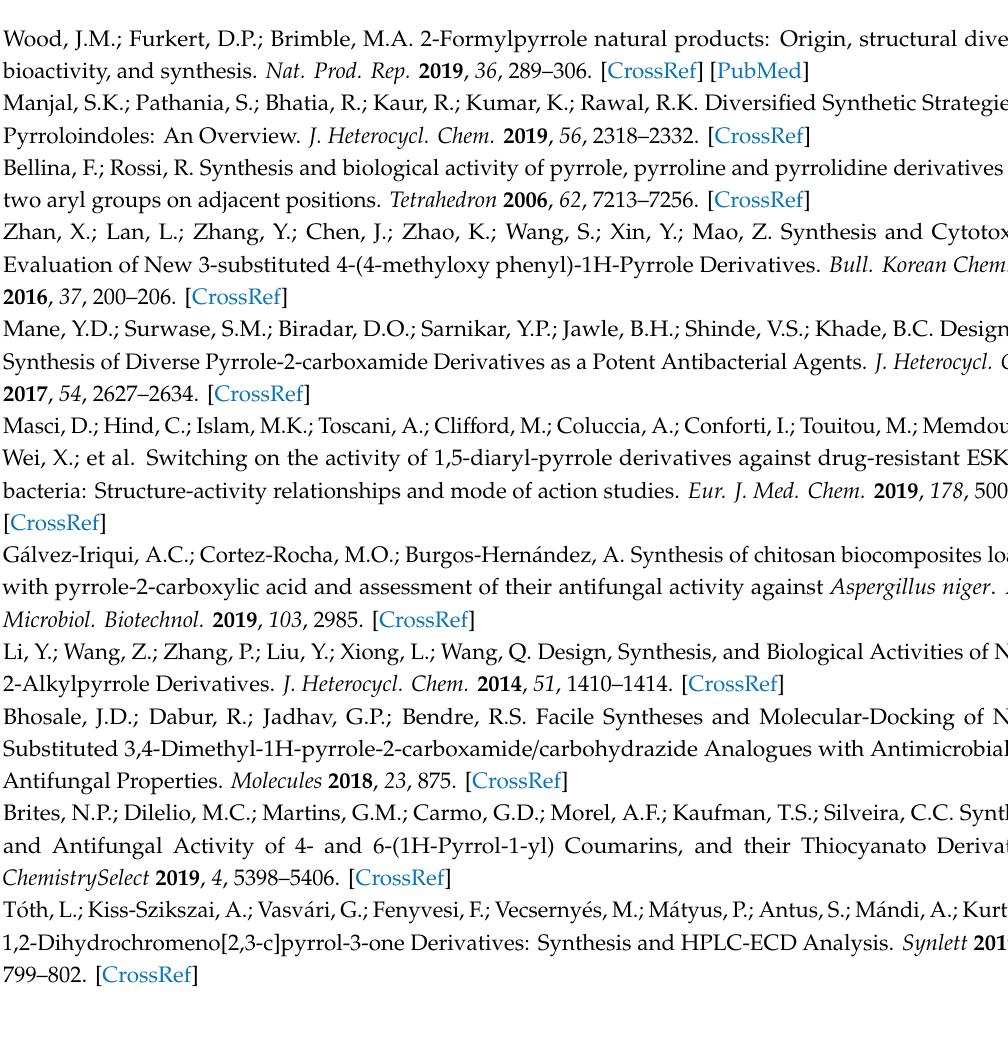
Supplementary Materials: The following are available online. Figure S1: 1 H NMR spectrum of 1a in CDCl 3 , Figure S2: 13 C NMR spectrum of 1a in CDCl 3 , Figure S3. HR-MS spectrum of compound 1a , Figure S4: 1 H NMR spectrum of 1b in CDCl 3 , Figure S5: 13 C NMR spectrum of 1b in CDCl 3 , Figure S6. HR-MS spectrum of compound 1b , Figure S7: 1 H NMR spectrum of 1c in CDCl 3 , Figure S8: 13 C NMR spectrum of 1c in CDCl 3 , Figure S9: 1 H NMR spectrum of 1d in CDCl 3 , Figure S10: 13 C NMR spectrum of 1d in CDCl 3 , Figure S11: HR-MS spectrum of compound 1d